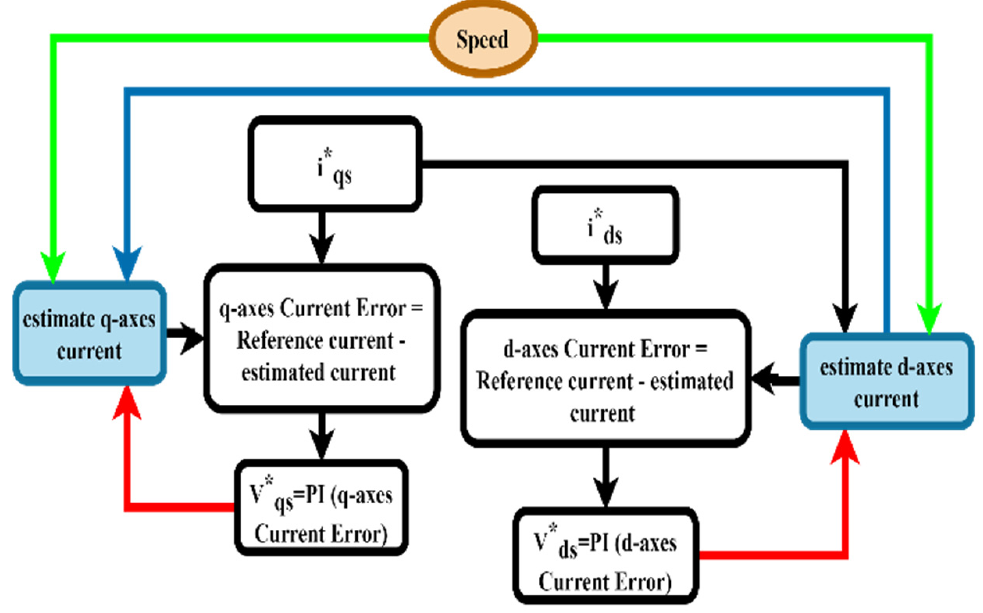
Figure 1. Flow chart for the current estimation method.